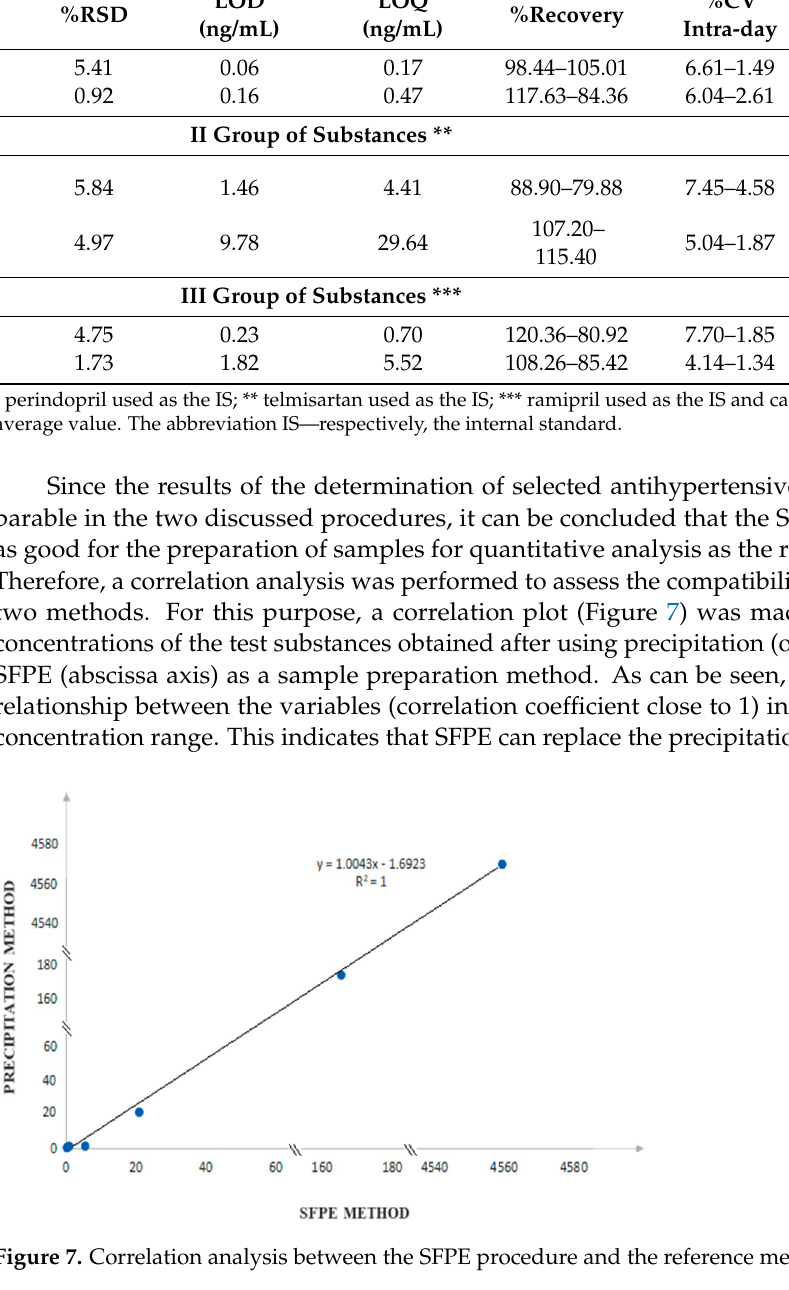
Table 4. The figures of merits of the SFPE procedure, calculated on the basis of the average (n = 5). Results obtained for three patients with resistant hypertension (each patient took a different group of drugs). The solute recovery is calculated from the formula Mx/dLC-MS × 100, where Mx- is the value of the peak area substance obtained with the use of LC-MS/MS method after sample preparation using the SFPE technique; dLC-MS is the value of the peak area substance in the standard solution obtained with the use of LC-MS/MS method without the use of the SFPE technique. %CV—coefficient of variation is calculated from the formula SD/Mean × 100, where SD is the standard deviation. I Group of Substances *